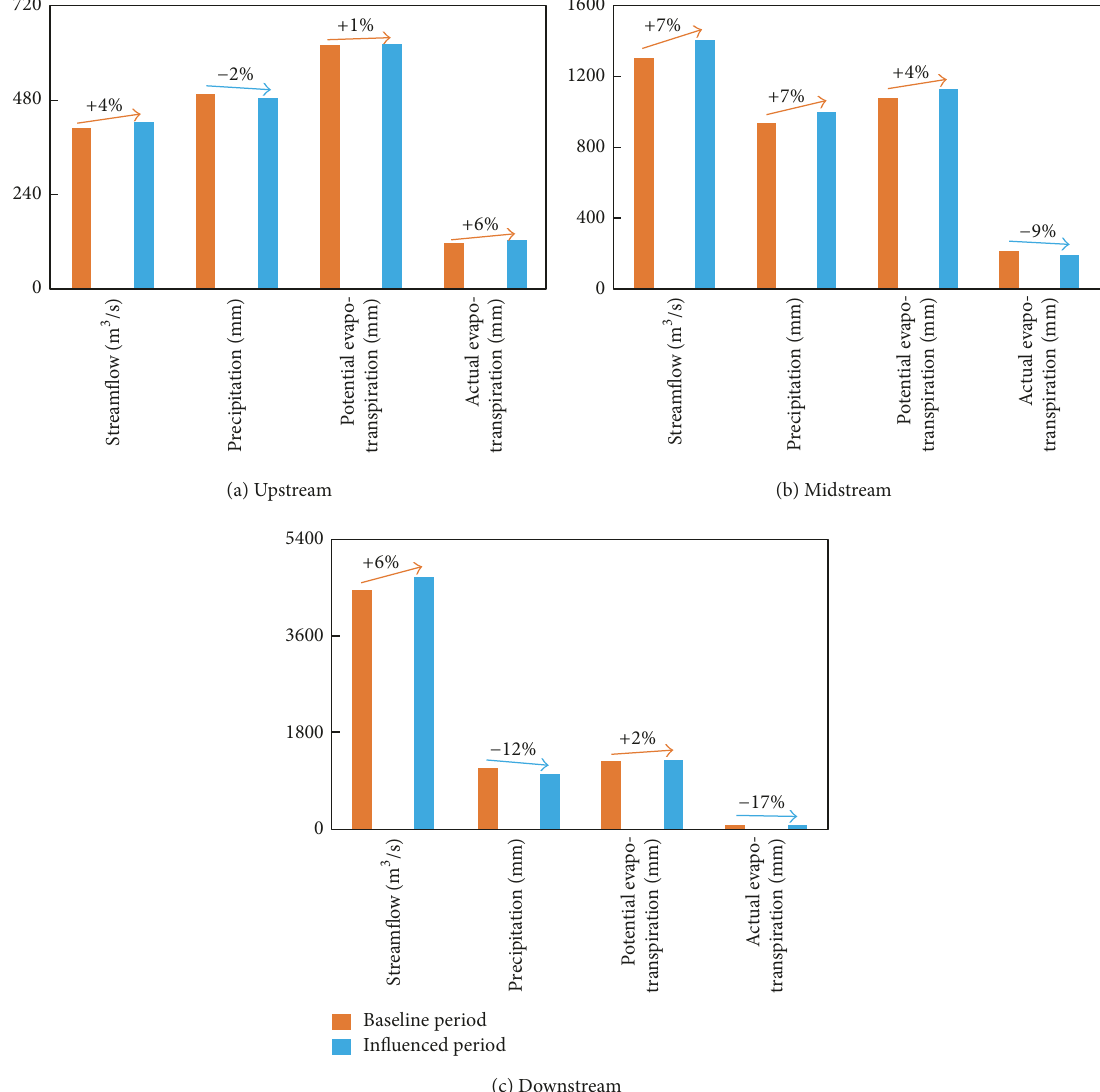
Figure 3: Variations of streamflow, precipitation, and potential and actual evapotranspiration from the baseline period to the change period at upstream, midstream, and